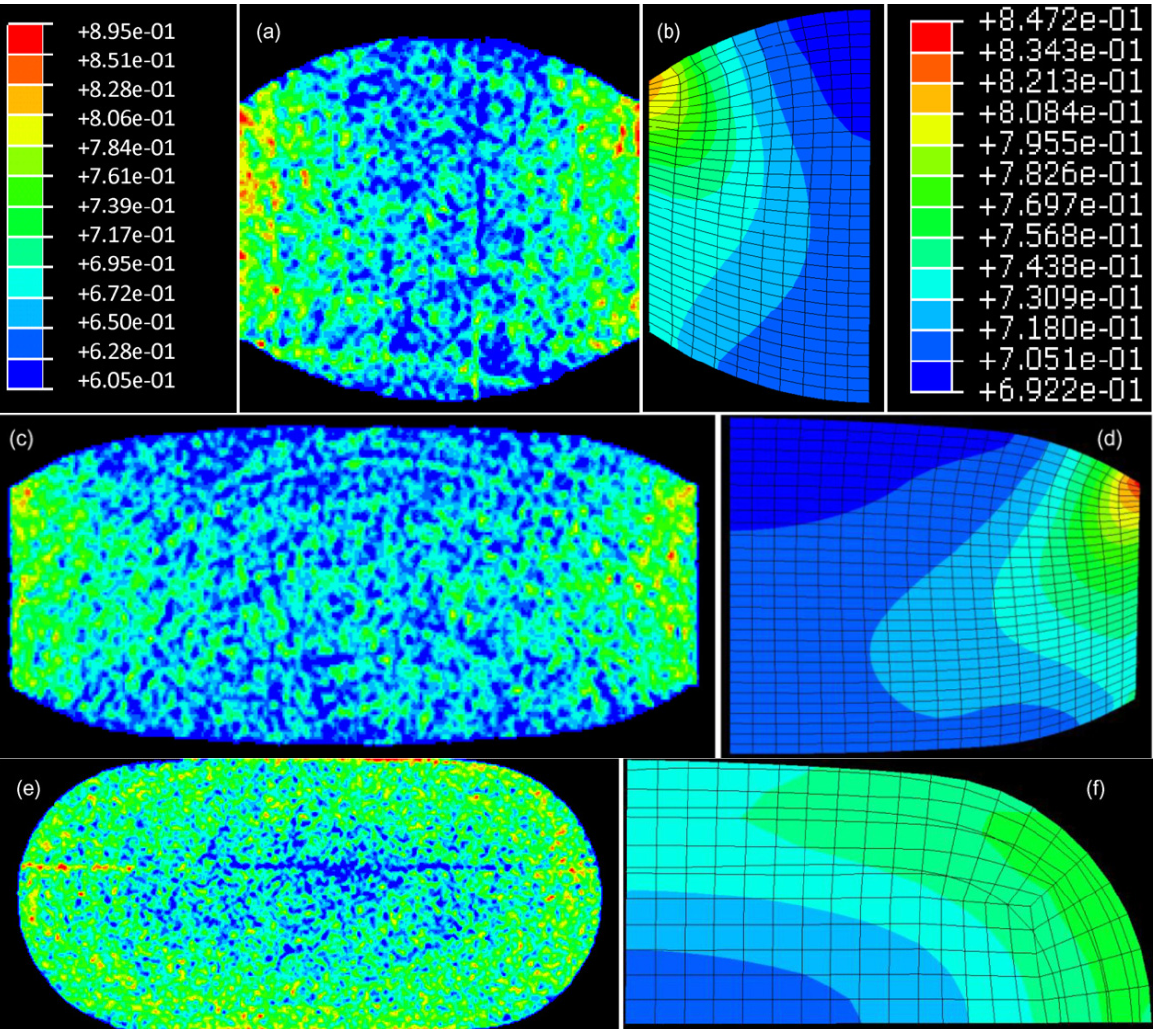
Figure 6. Microcomputed tomopraphy relative density cross ‐ sections (left column) and correlating simulation cross ‐ sections (right column) of a convex tablet (color contour scales represent relative density values). Reprinted with permission from Ref. [106] .